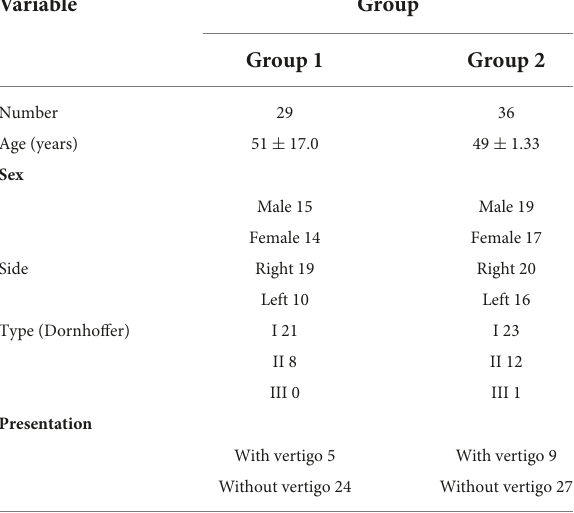
TABLE 1 Characteristics of participants in groups 1 and